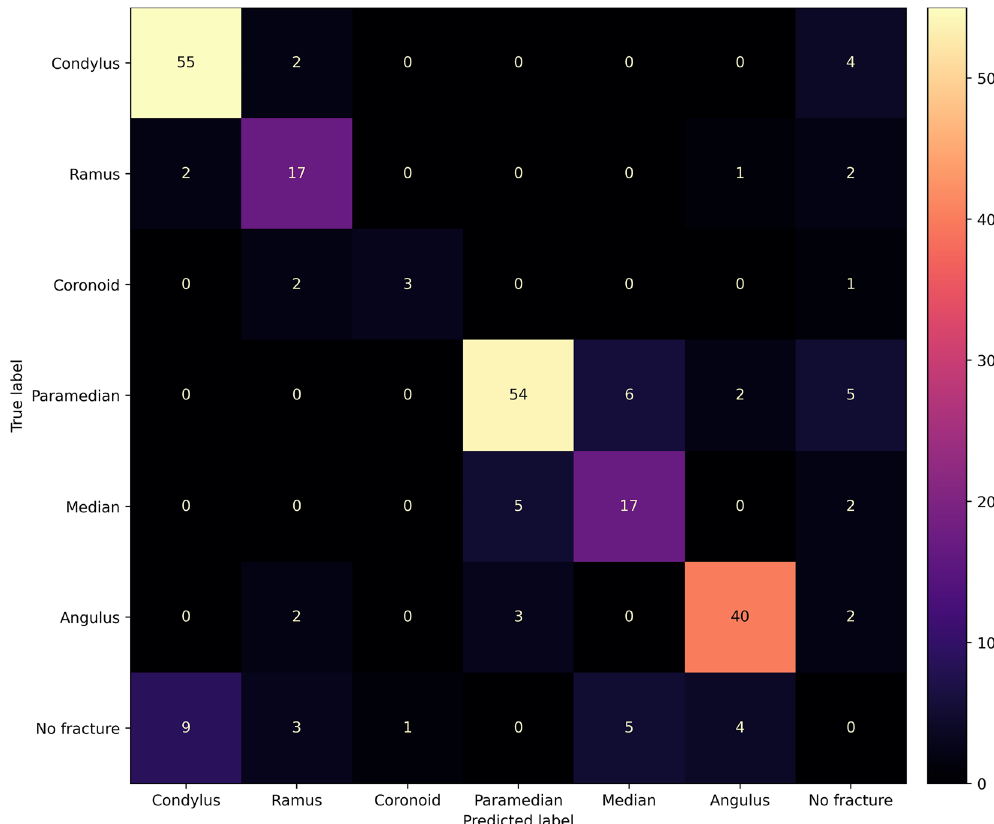
Figure 6. Confusion matrix illustrating the multi-class detection results of mandibular fractures (instance level) on PR. Instance level analysis takes multiple fractures into consideration on each OPG. True negatives were excluded so as not to confuse instance level analysis with image level analysis.